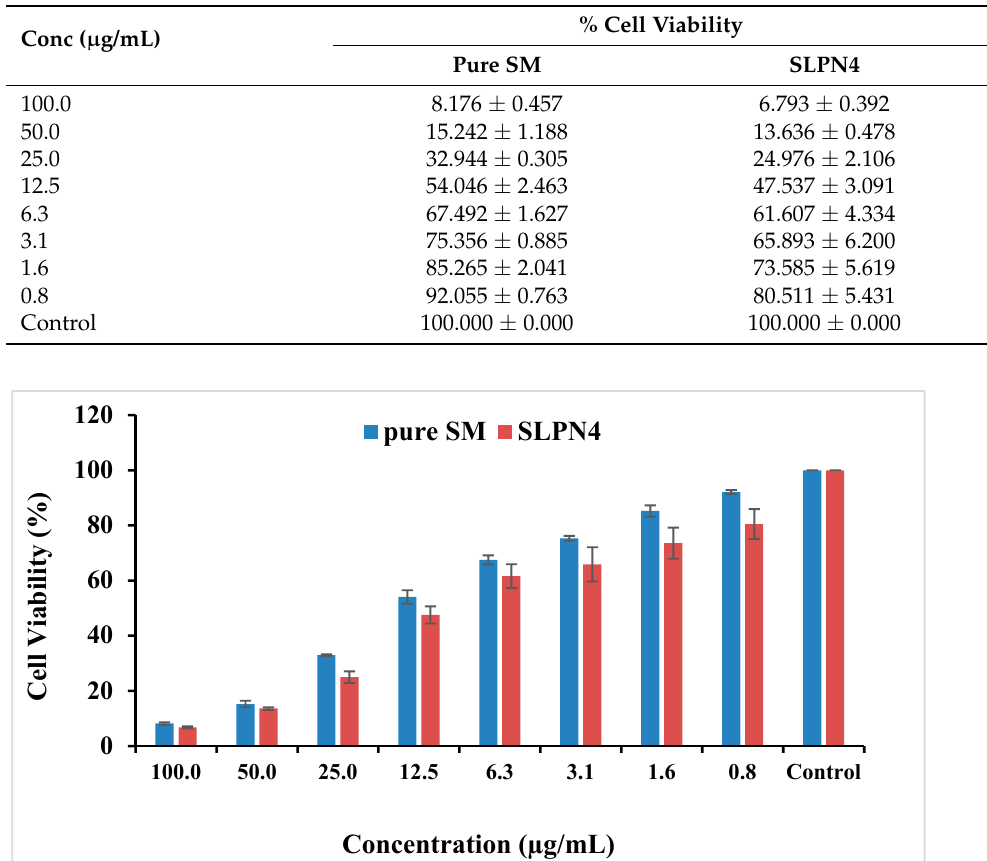
Figure 7. SEM images of optimized LPHNPs (SLPN4). Table 2. Percent cell viability against concentration. Table 2. Percent cell viability against concentration.